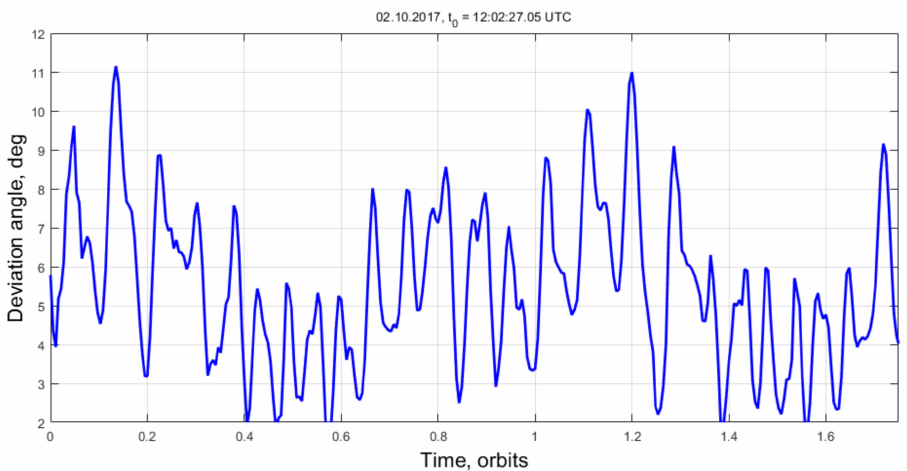
Figure 9. Deviation from the direction of the local magnetic